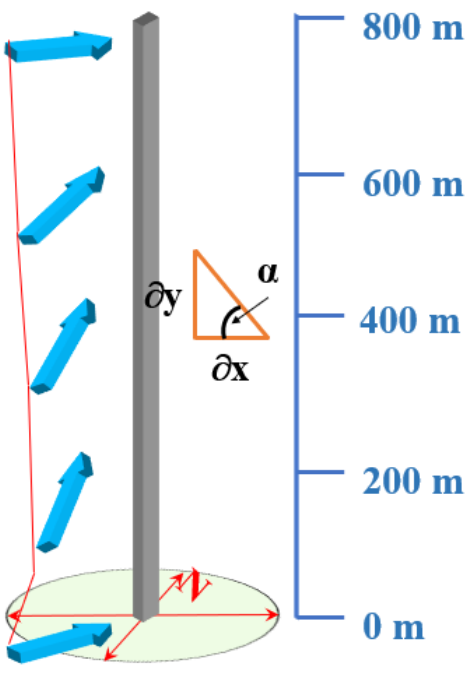
Figure 16. Sketch of wind-direction deflection rate.